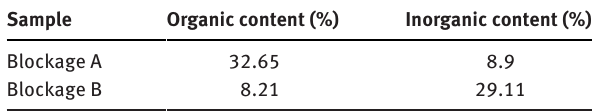
Table 3: Organic and Inorganic content of polymer blockages.